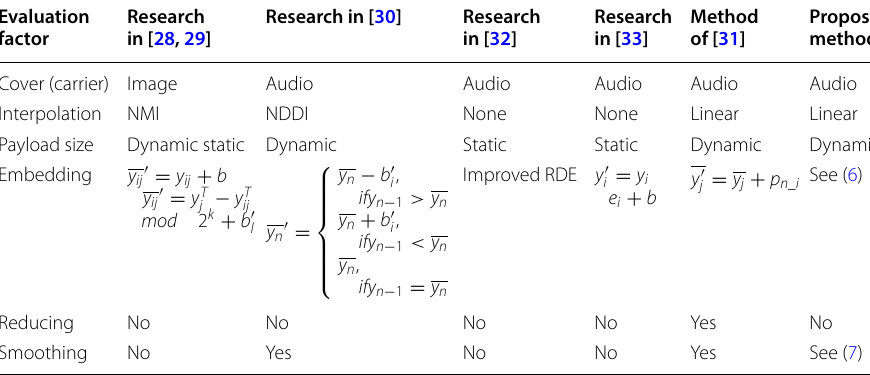
Table 1 Summary of the data hiding techniques in [28–33] and the proposed method (inspired by [30,